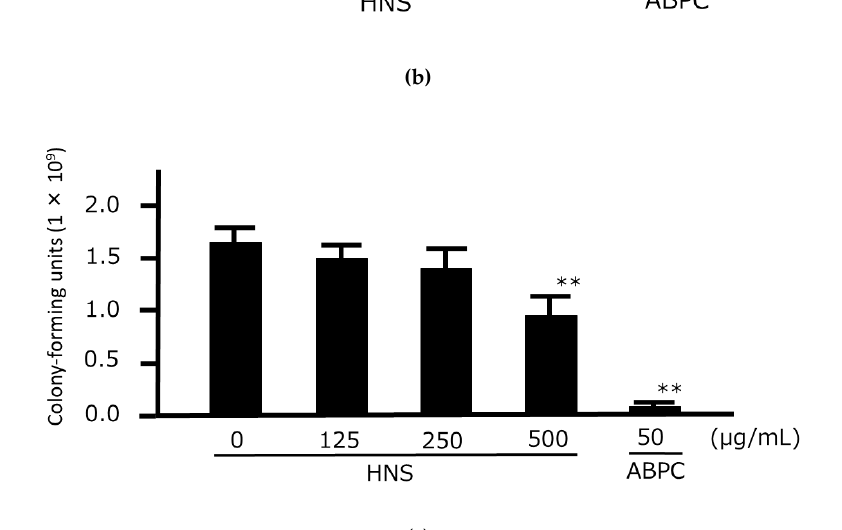
means ± SD (n = 3). * p < 0.05, ** p < 0.01 vs. the untreated group (Tukey’s multiple comparison